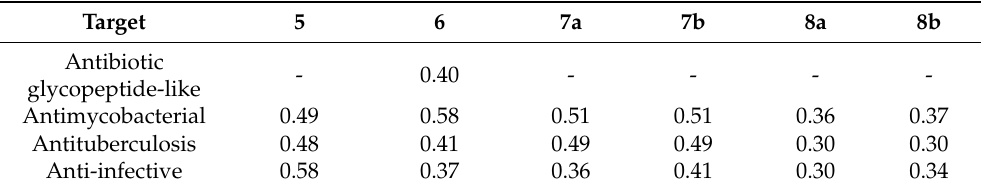
Table 1. PASS predicted the probabilities that the new compounds 5 , 6 , 7a , b , and 8a , b to be active (Pa) as antimicrobial agents.